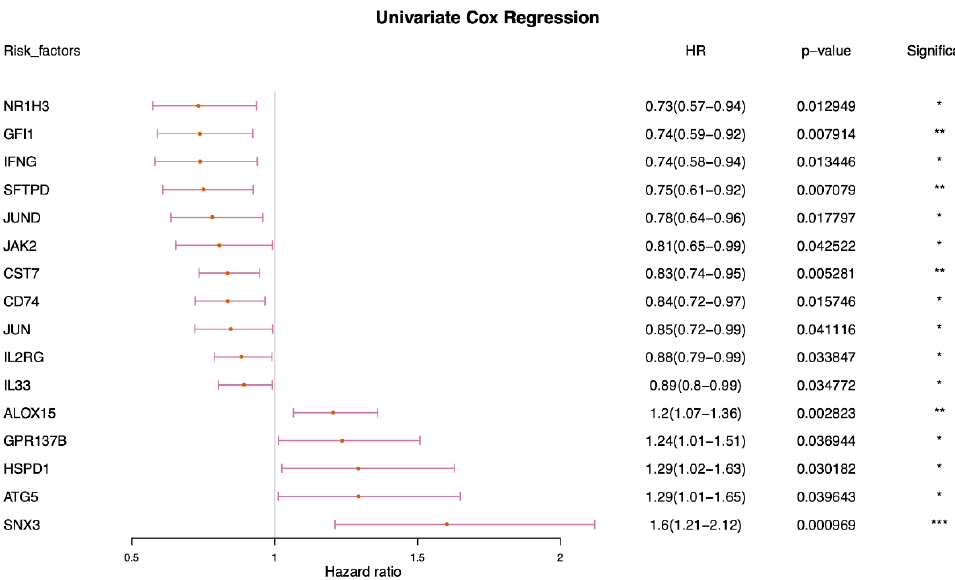
Figure 6. Univariate Cox analysis of phagocytosis regulatory factors. (* p < 0.05, ** p < 0.01, *** p < 0.001).